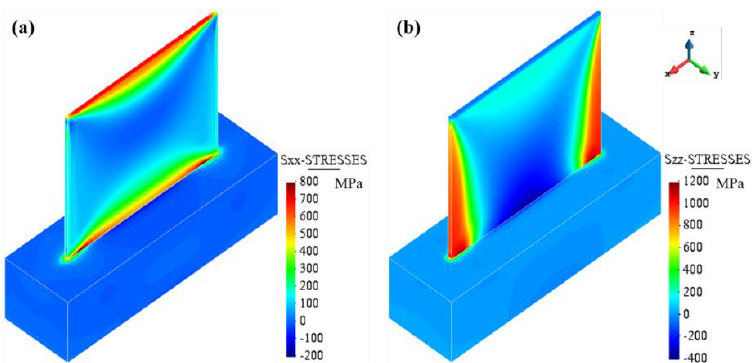
Figure 6. Residual stress distribution of the single − wall part at the end of the printing: ( a ) longitu- dinal σ xx stresses; ( b ) vertical σ zz stresses.